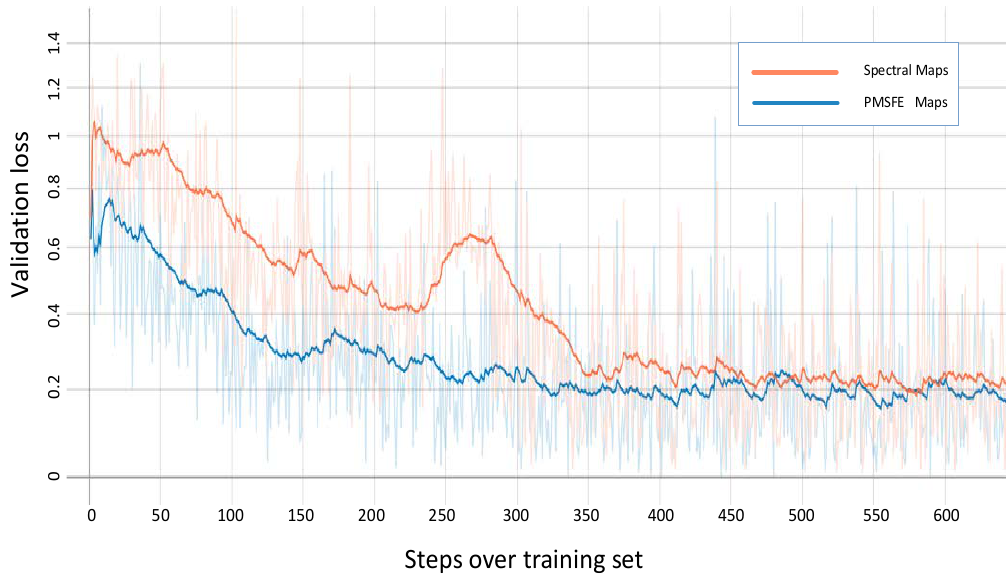
Figure 6. Validation loss of spectral maps and PMSFE maps over training set using AlexNet. (Smooth = 0.95 in Tensorboardx).